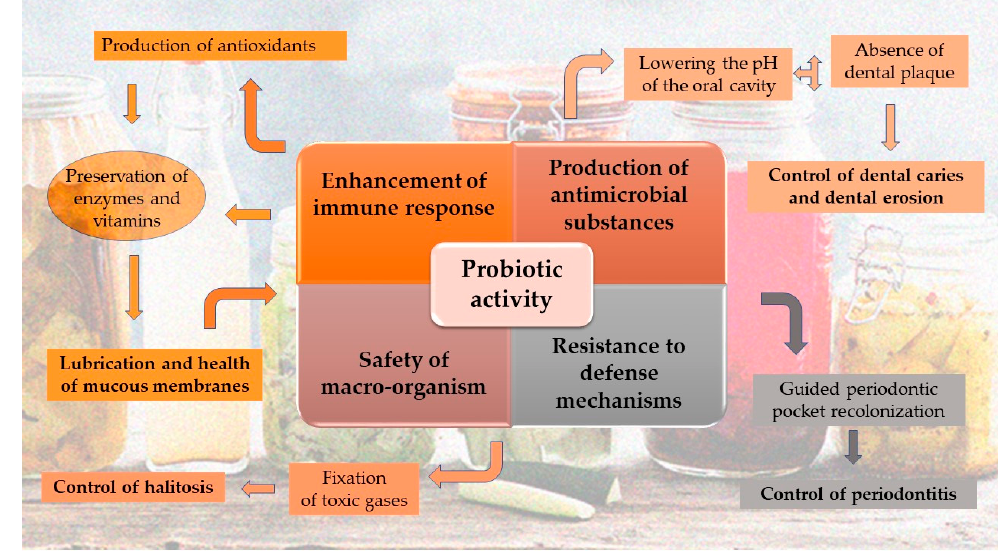
Figure 2. Mechanisms and advantages of action of fermented foods in the oral cavity.